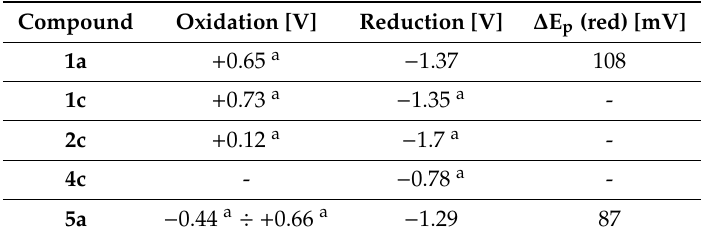
Table 2. Overview of the main oxidation and reduction potentials (V vs. Fc + / Fc) at a scan rate of 100 mV / s determined by cyclic voltammetry in MeCN for selected iron complexes. The peak-to-peak separation ( ∆ E p ) is determined by the di ff erence between two peak potentials for a given redox couple. a E pa for an irreversible